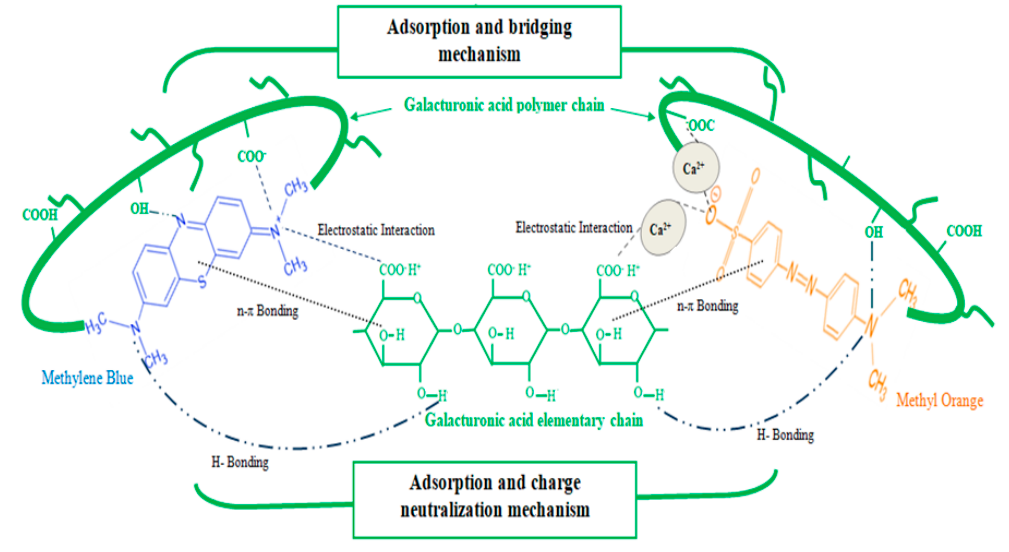
Figure 6. Illustration for the flocculation mechanisms with polygalacturonic acid and its di ff erent interactions with the dyes.